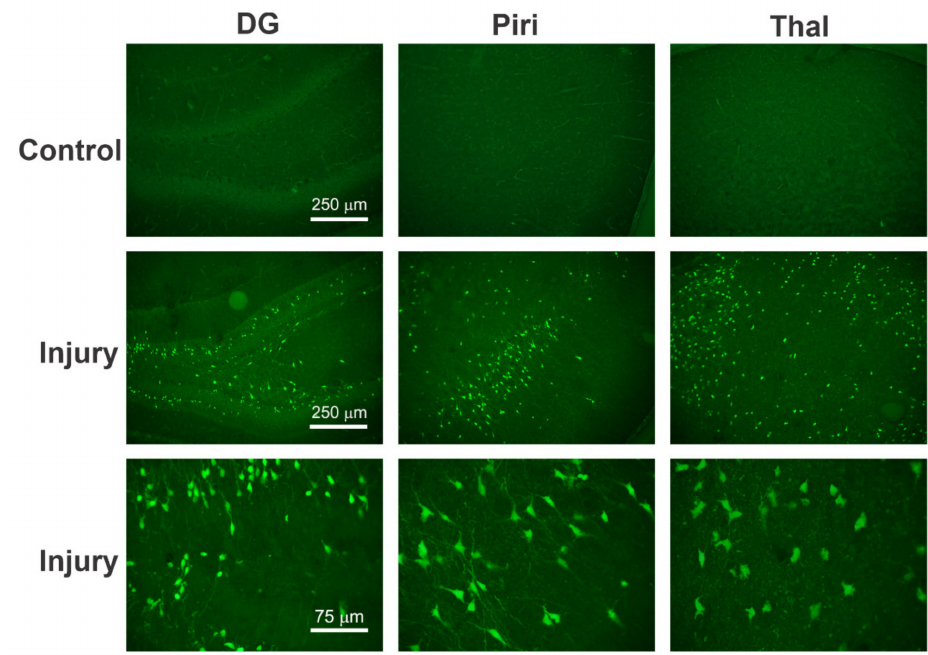
Figure 4. FJB(+) fluorescent histology of injured and necrotized neurons in the brain . Representa- tive images of FJB(+) immunostaining depicting dying neurons in the brain sections of rats